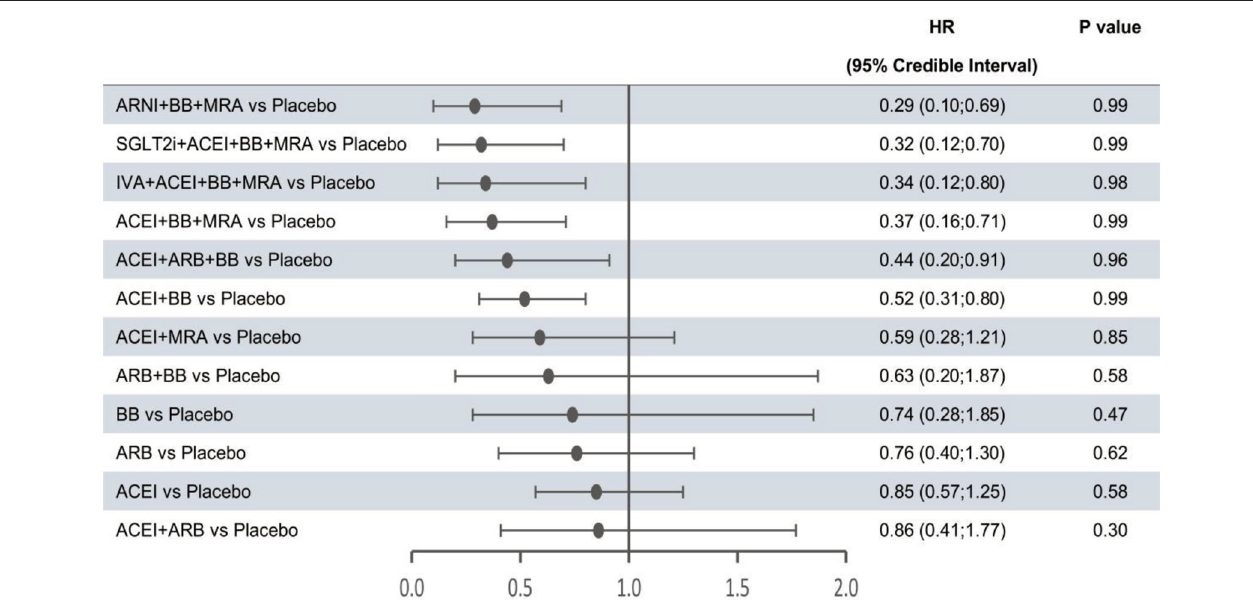
hospitalization for HF ( Figure 4 ) were more significant than differences in efficacy in reducing all-cause or cardiovascular